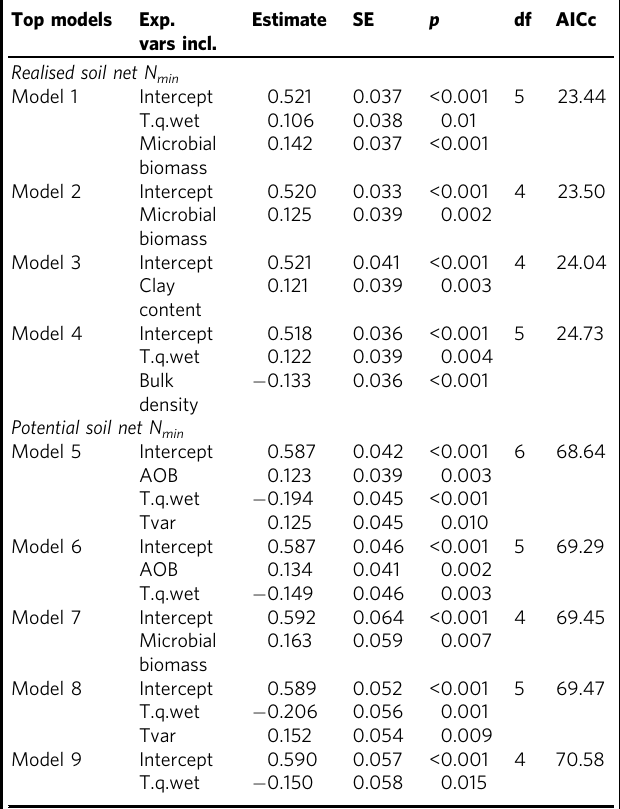
Table 2 Model selection results for realised soil net N min and potential soil net N min starting with the full model including all explanatory variables (Supplementary Table 5) followed by multi-model inference to select the simplest models that explained the most variation in realised and potential soil net N